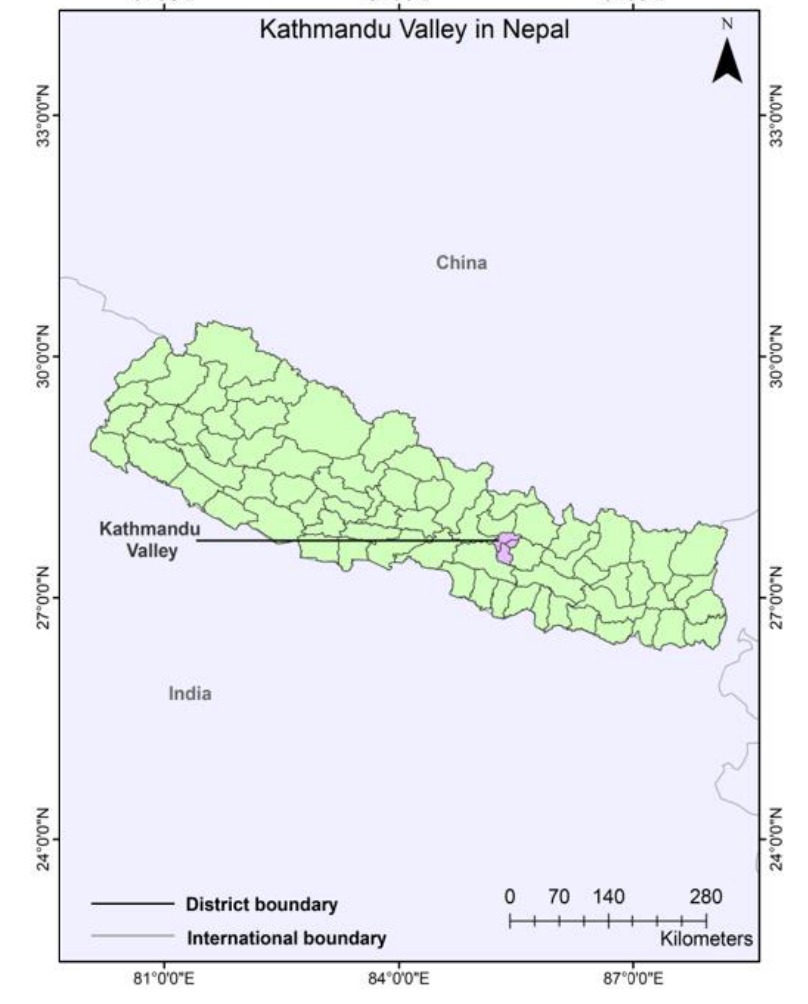
Figure 8. Map showing Kathmandu Valley in Nepal (Authors, 2022).